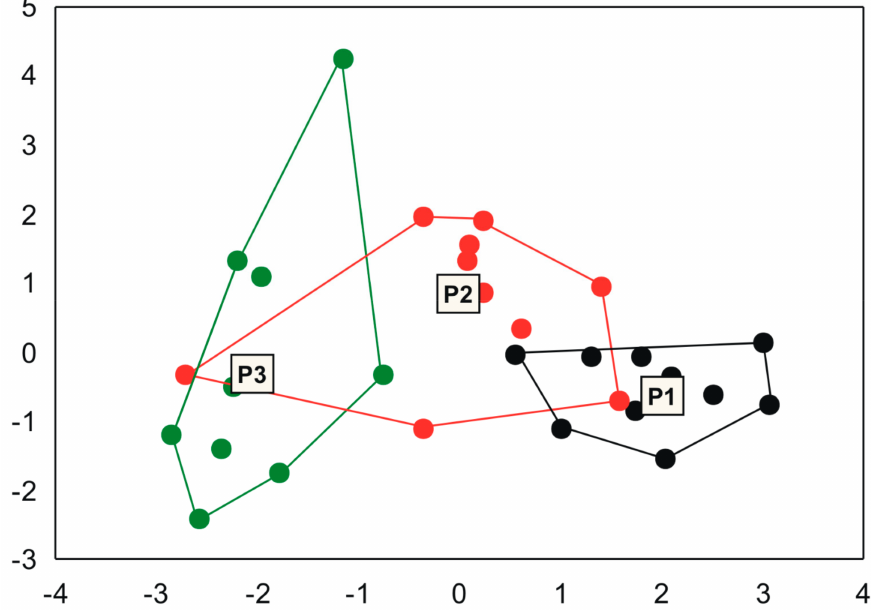
Figure 3. Variation in environmental conditions between Ponds 1, 2, and 3 in the Pantanal